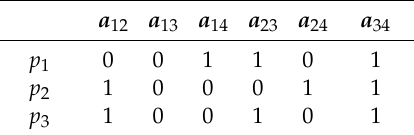
Table 4. Information table